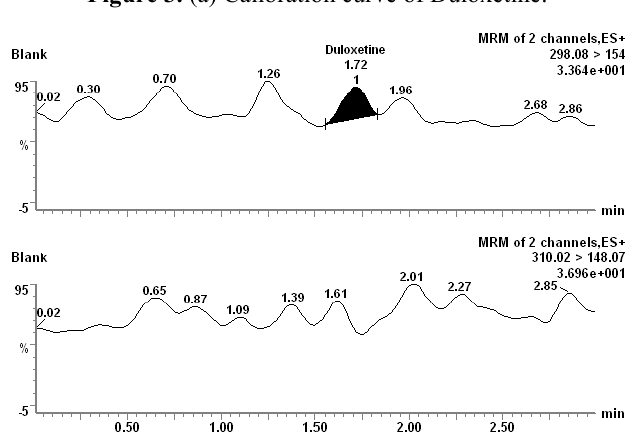
Figure 3. (a) Calibration curve of Duloxetine.